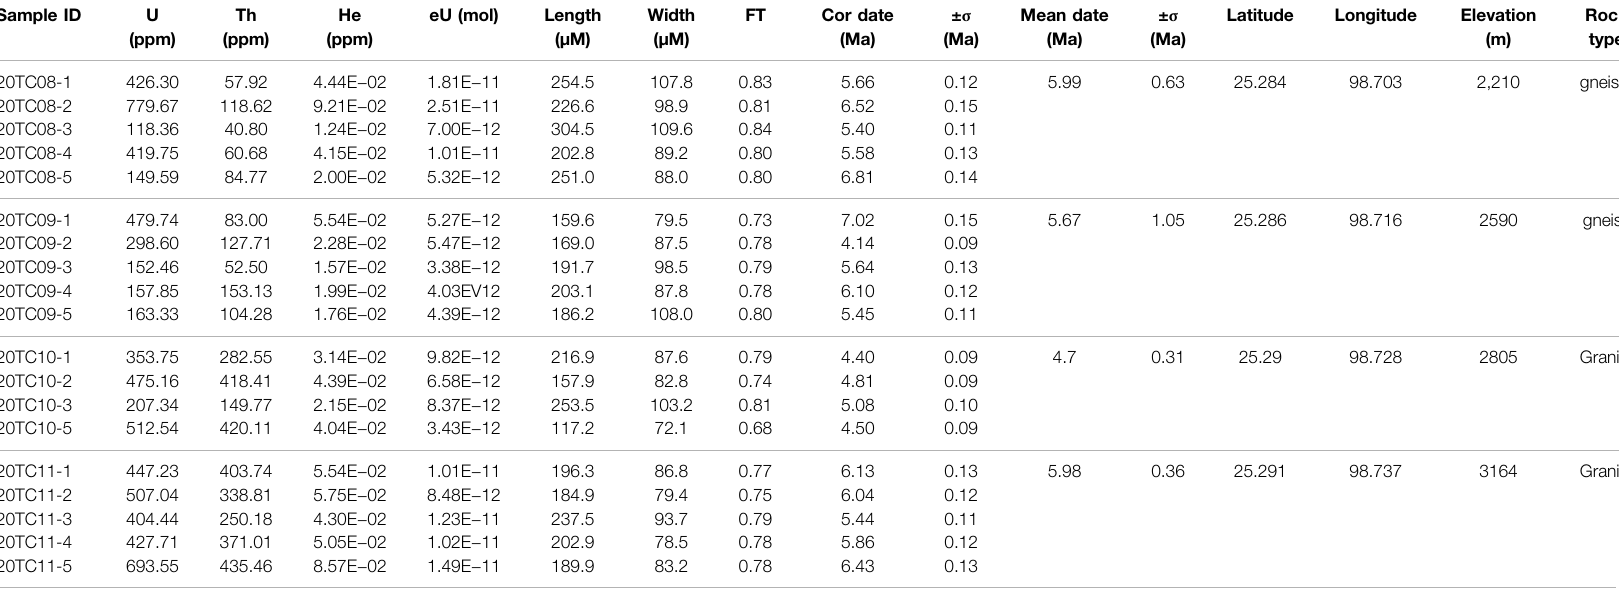
TABLE 2 | Results of the zircon single particle (U-Th)/He analysis in the Gaoligong ductile shear zone